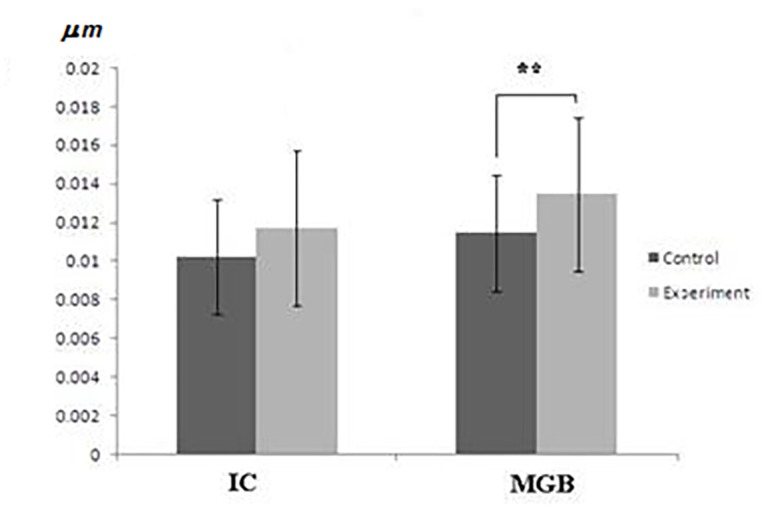
The neuronal porosome depth (mm) in cat brainIC – inferior colliculi, MGB – medial geniculate body; * - p < 0.05, ** - p < 0.01